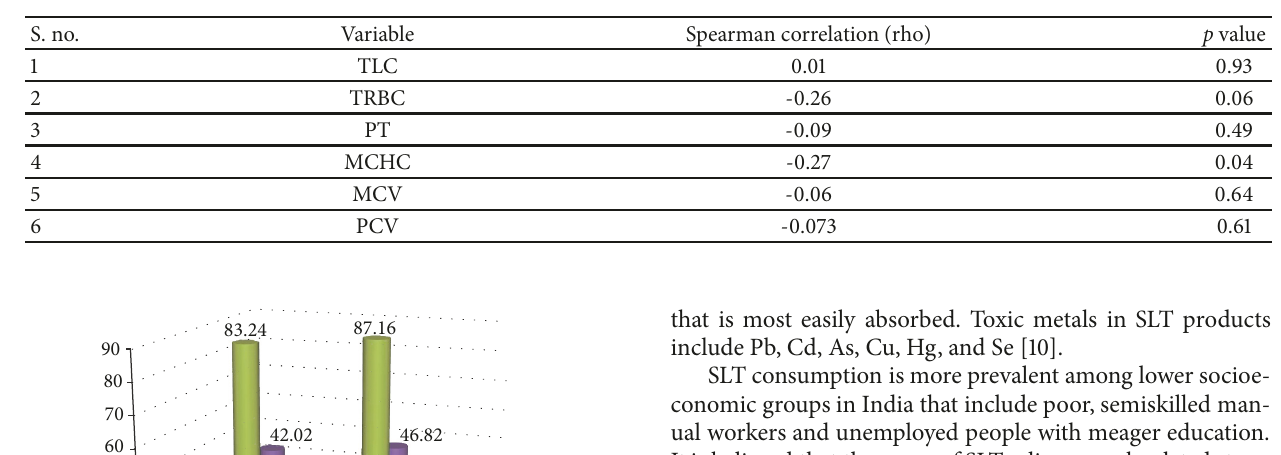
Table 3: Correlation of form of smokeless tobacco with blood profile.